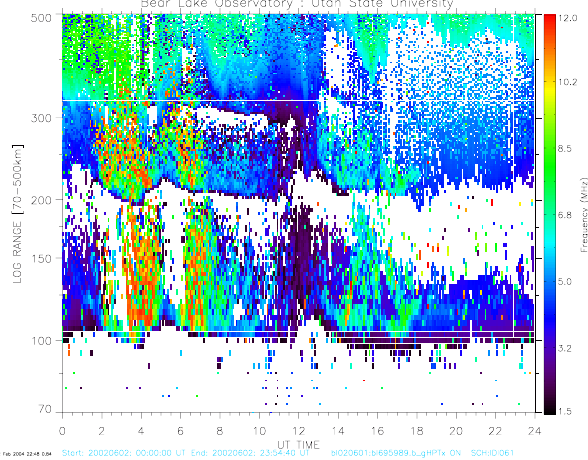
Fig. 2. Contour plot of the Bear Lake ionosonde reflection fre- quency.